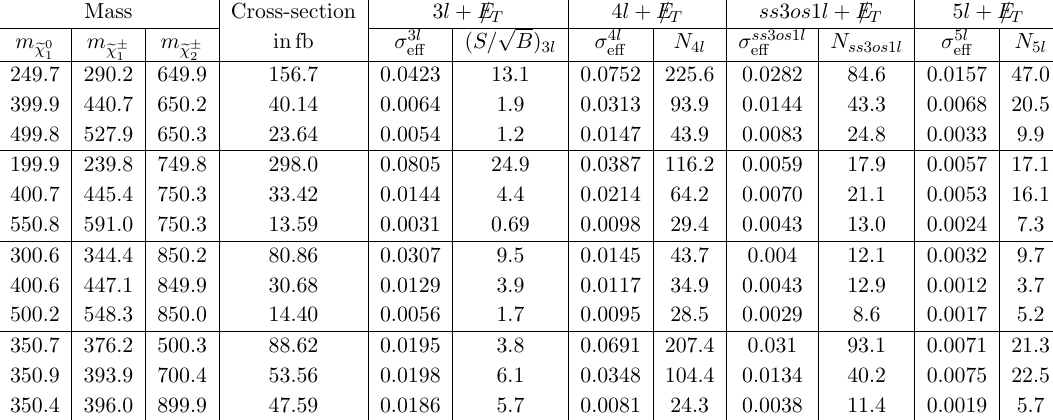
Table 3 . The masses and production cross-sections of all possible eweakino pairs for di(cid:11)erent BPs in the CLHHS ( f W ) model are given. For the trilepton signal in each case we display the signi(cid:12)cance p ( S= B ). The corresponding (cid:27) e(cid:11) and total number of signal events (with negligible backgrounds) for each type of multilepton signal with n > 3 are also shown. Masses and cross-sections are in GeV and fb